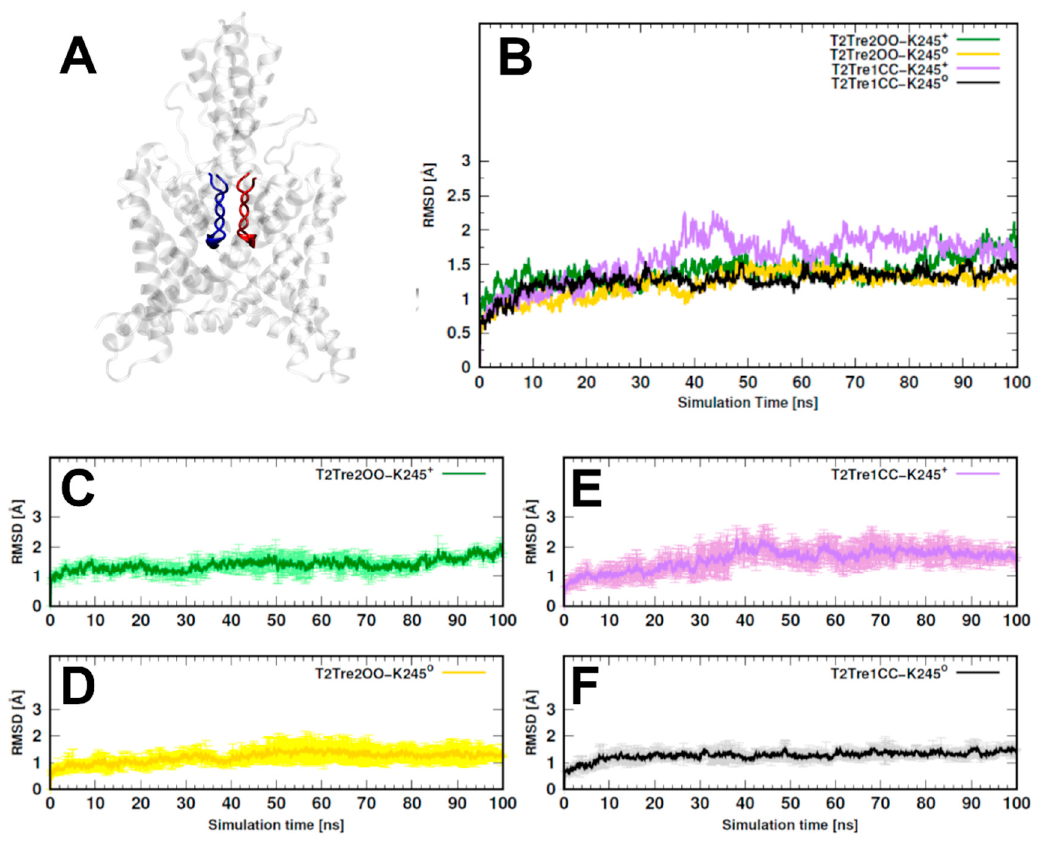
Figure 2. Root Mean Square Deviation (RMSD) values evaluated in the selectivity filter of TASK-2 homology models during molecular dynamics (MD) simulations. The time dependence of the RMSD values calculated over the residues 97–103 and 203–208 for both monomers. ( A ) An example of T2Tre1CC showing the selectivity filter of both monomers in red and blue colors; the transparent gray region was not considered in this RMSD calculation; ( B ) RMSD averaged over three replicas for all systems. Averages and standard deviations of RMSD values for T2Tre2OO-K245 + in green color are depicted in ( C ), and those for T2Tre2OO-K245 0 in yellow are shown in ( D ); Correspondingly to ( C , D ), values for the T2Tre1CC model are shown in ( E , F ).